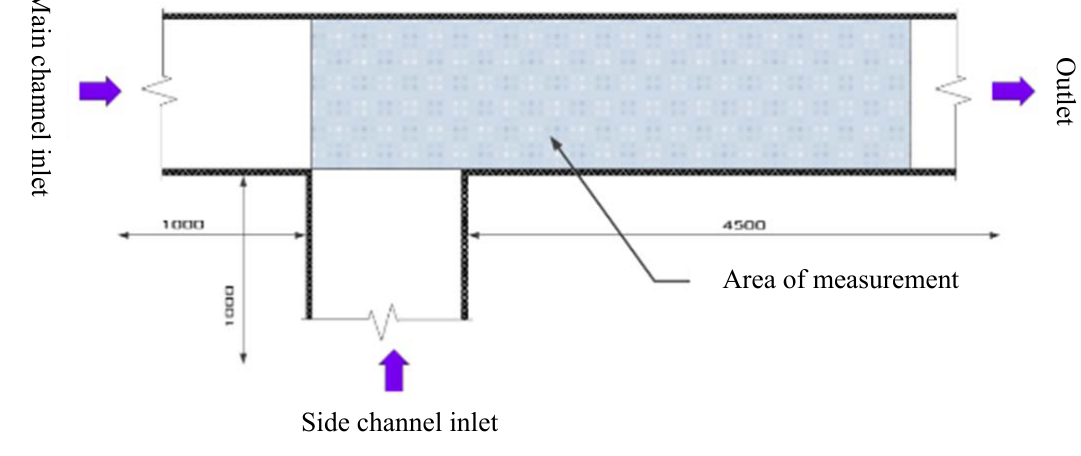
Figure 1. Conditions at the test site with dimensions